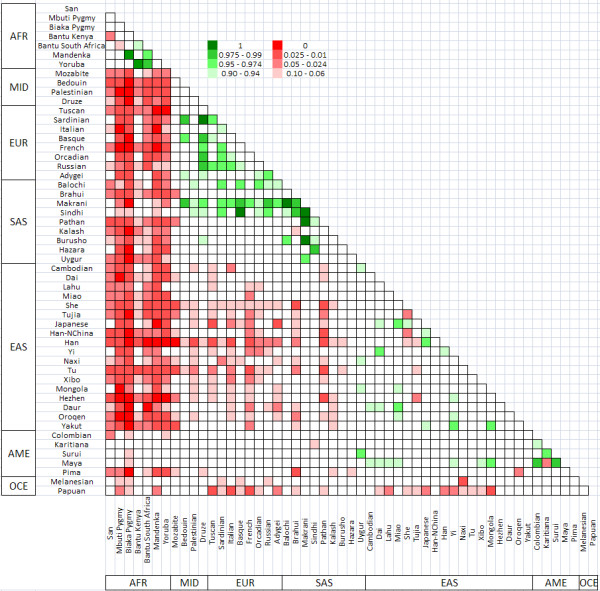
Pairwise FST matrix for all 53 populations for the 400 Kb region surrounding rs2395029 compared to the rest of the chromosome. Extremely high FST values from 0.9 to 1.0 are shown in shades of green, where the darkest green represents the 100th percentile and the lightest green represents the 90th - 95th percentile. Extremely low FST values are shown in shades of red, where the darkest red represents the 0th percentile and the lightest red represents the 5th - 10th percentile. (AFR: sub-Saharan Africa; MID: Middle East; SAS: South Asia; EUR: Europe; EAS: East Asia; OCE: Oceania; AME: Americas)